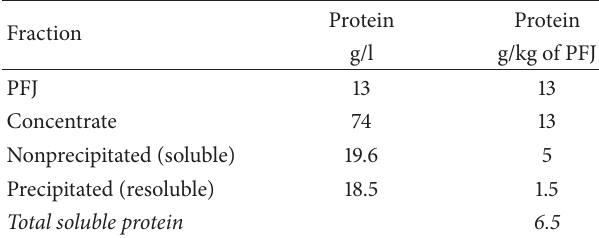
Figure 4: SDS-PAGE of proteins in native PFJ and its processed fractions. 1: PFJ; 2: concentrate; 3, 4, and 5: supernatant from pre- cipitation with 10.4 M ethanol (in triplicate); 6, 7, and 8: resolubilized protein in Tris buffer (in triplicate). Table 3: Mass balance of total protein in the PFJ and its processed fractions.